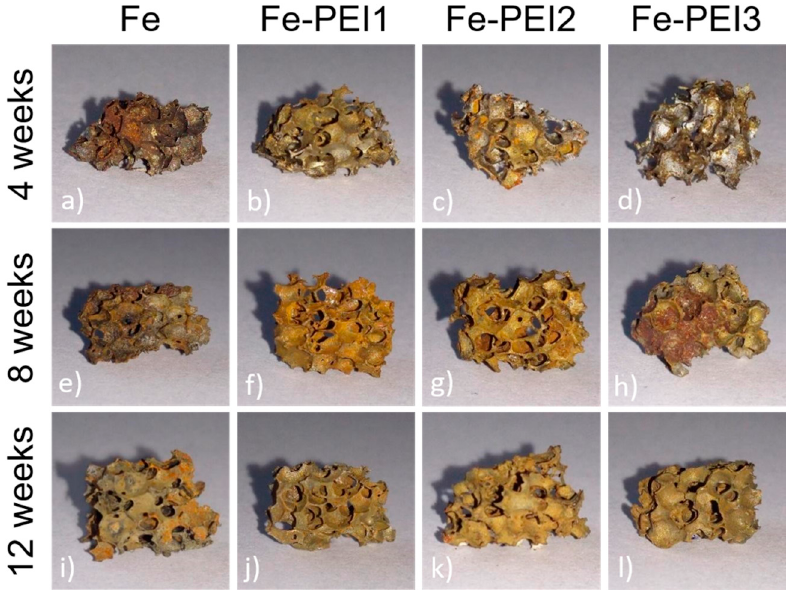
Figure 7. Cellular scaffold made of ( a , e , i ) pure Fe ; ( b , f , j ) Fe-PEI1; ( c , g , k ) Fe-PEI2; and ( d , h , l ) Fe-PEI3 after a static immersion test in Hanks’ solution at 37 °C.